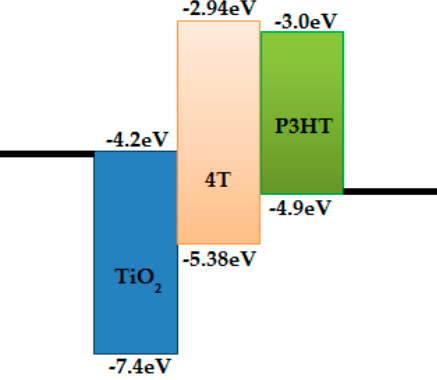
Figure 6. Schematic energy band diagram of the TiO 2 /4T/P3HT solar cell. 182